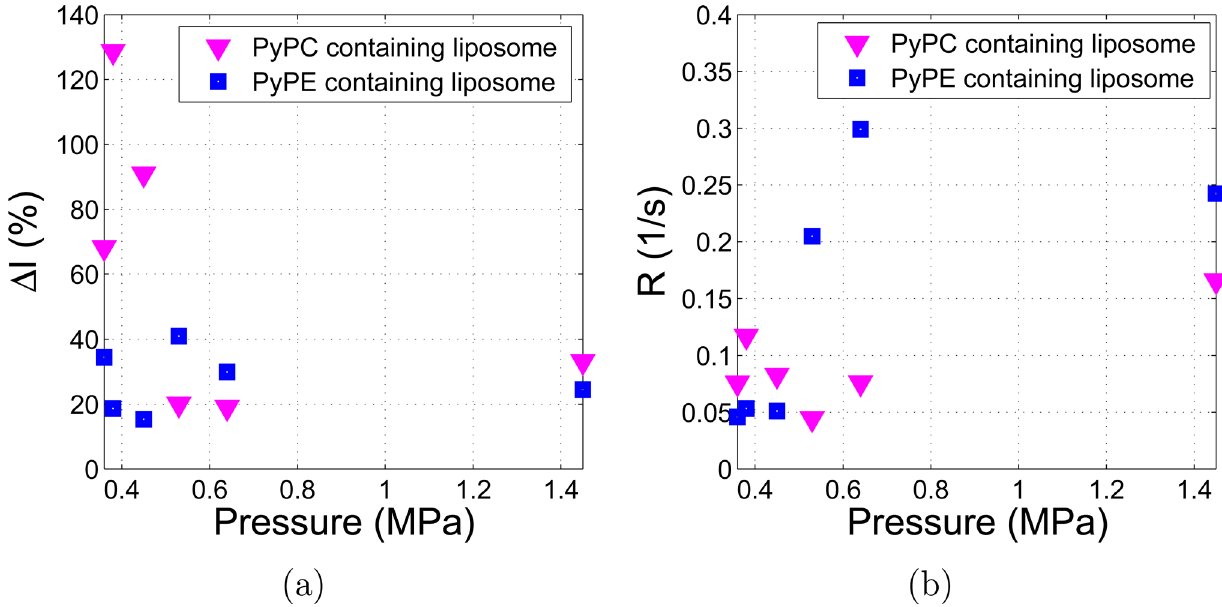
Fig 5. Comparison of PyPC and PyPE labelled liposomes. (a) Change in fluorescence intensity ( Δ I ) against US pressure; (b) rise rate ( R ) against US pressure.